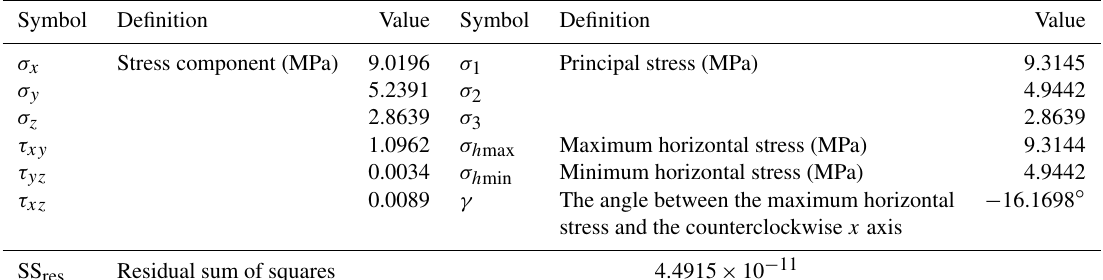
Table 10. Stress inversion